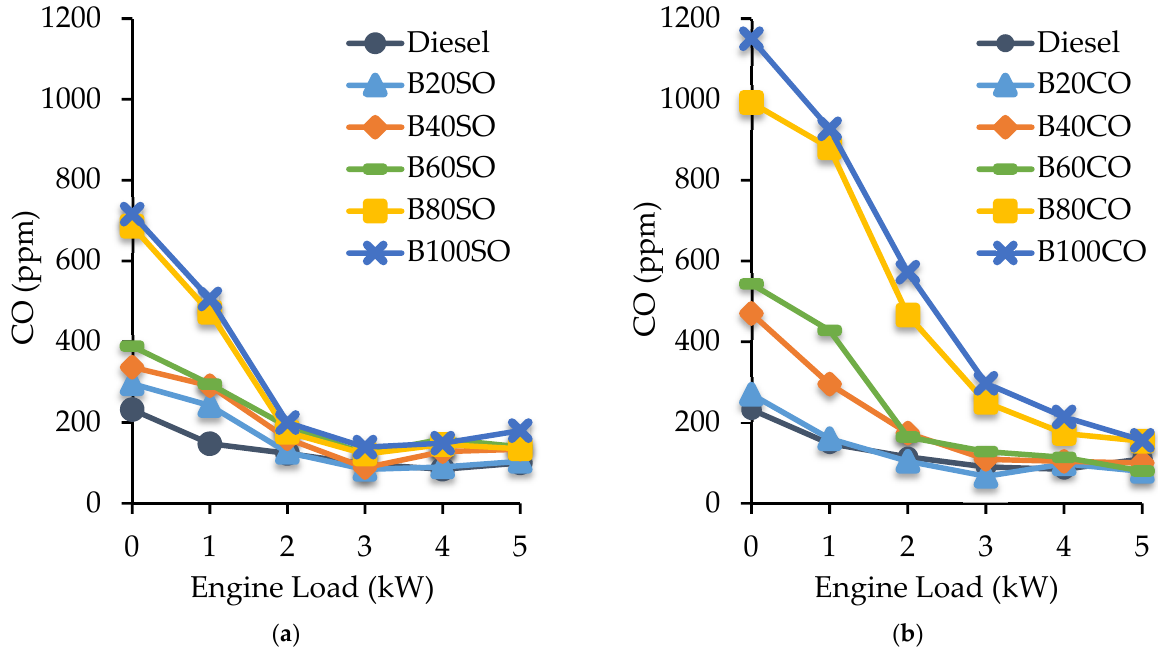
Figure 6. Carbon monoxide (CO) emissions (ppm) generated under different engine operating powers (from 0 to 5 kW), using the triple blends: diesel/ABE/sunflower oil ( a ) and diesel/ABE/castor oil ( b ).